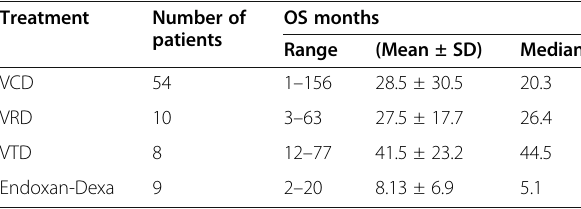
Table 3 Overall survival (OS) regarding different treatment